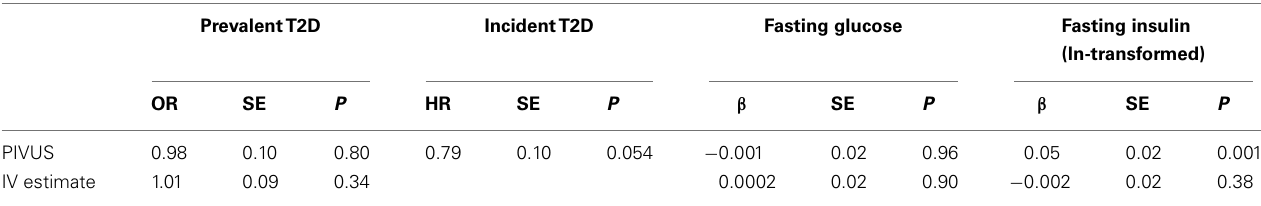
Table 3 |The association of homocysteine with diabetes and related traits in the PIVUS cohort and in causal analysis using large genome-wide association studies